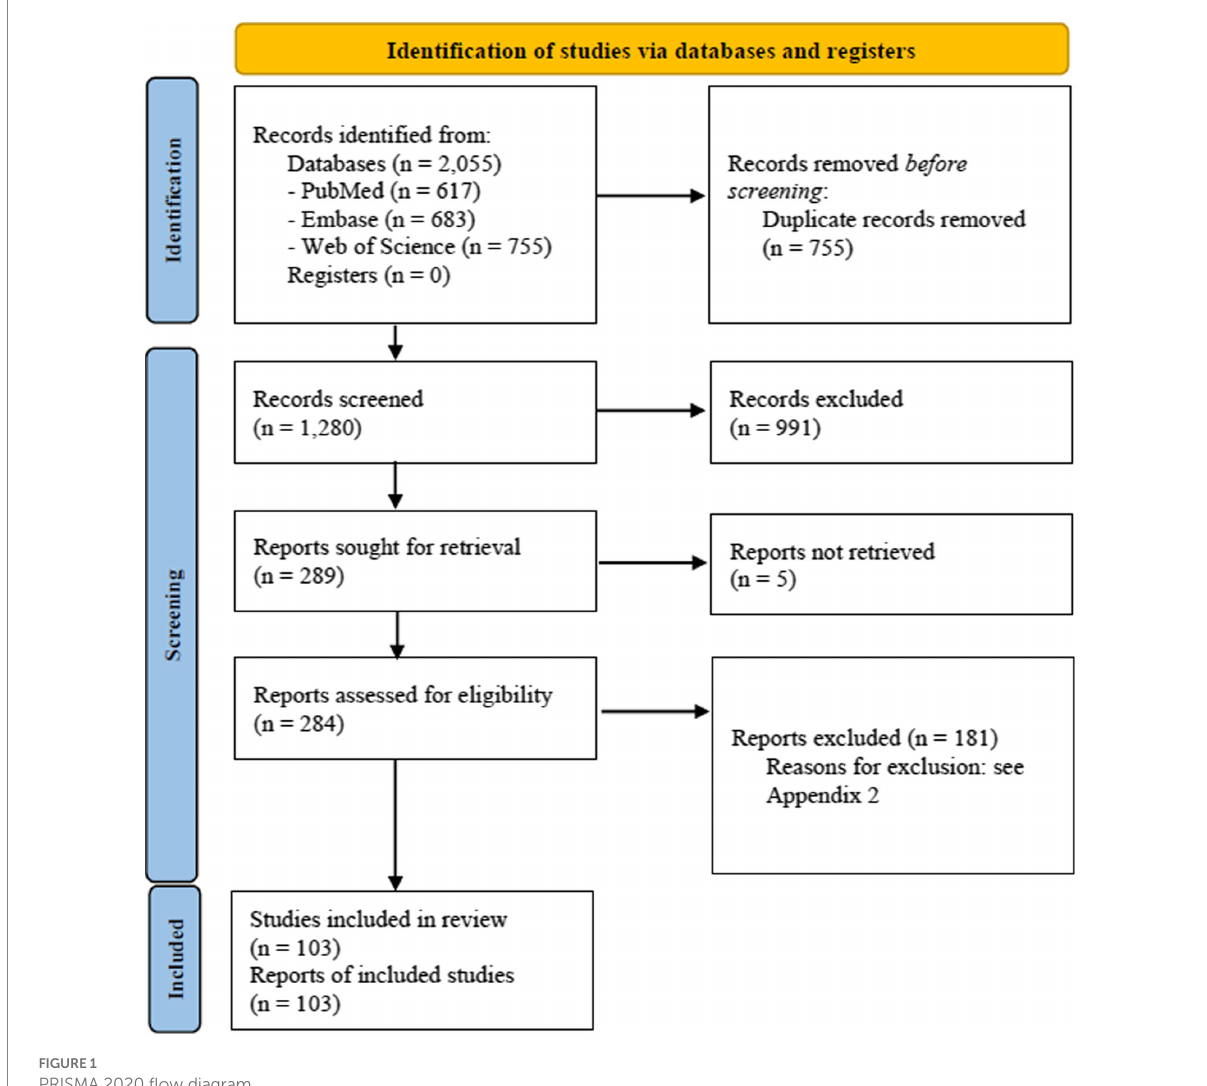
FIGURE 1 PRISMA 2020 flow